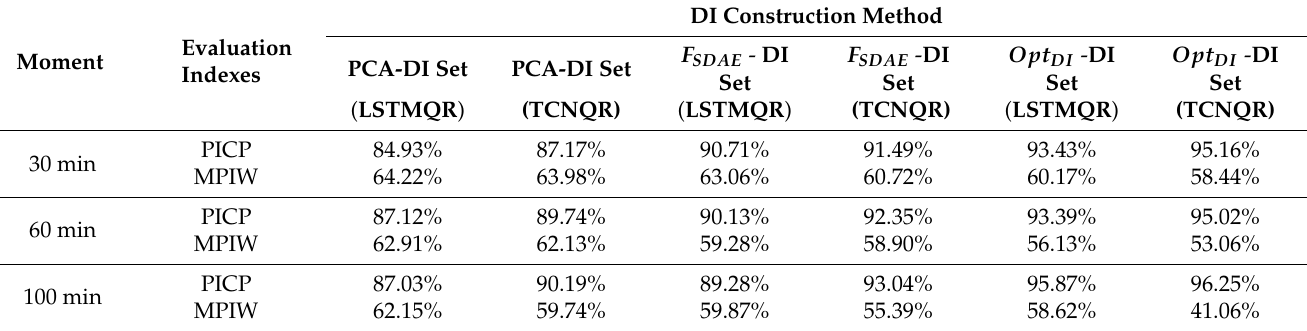
Table 4. Reliability and clarity comparison of prediction results at three different